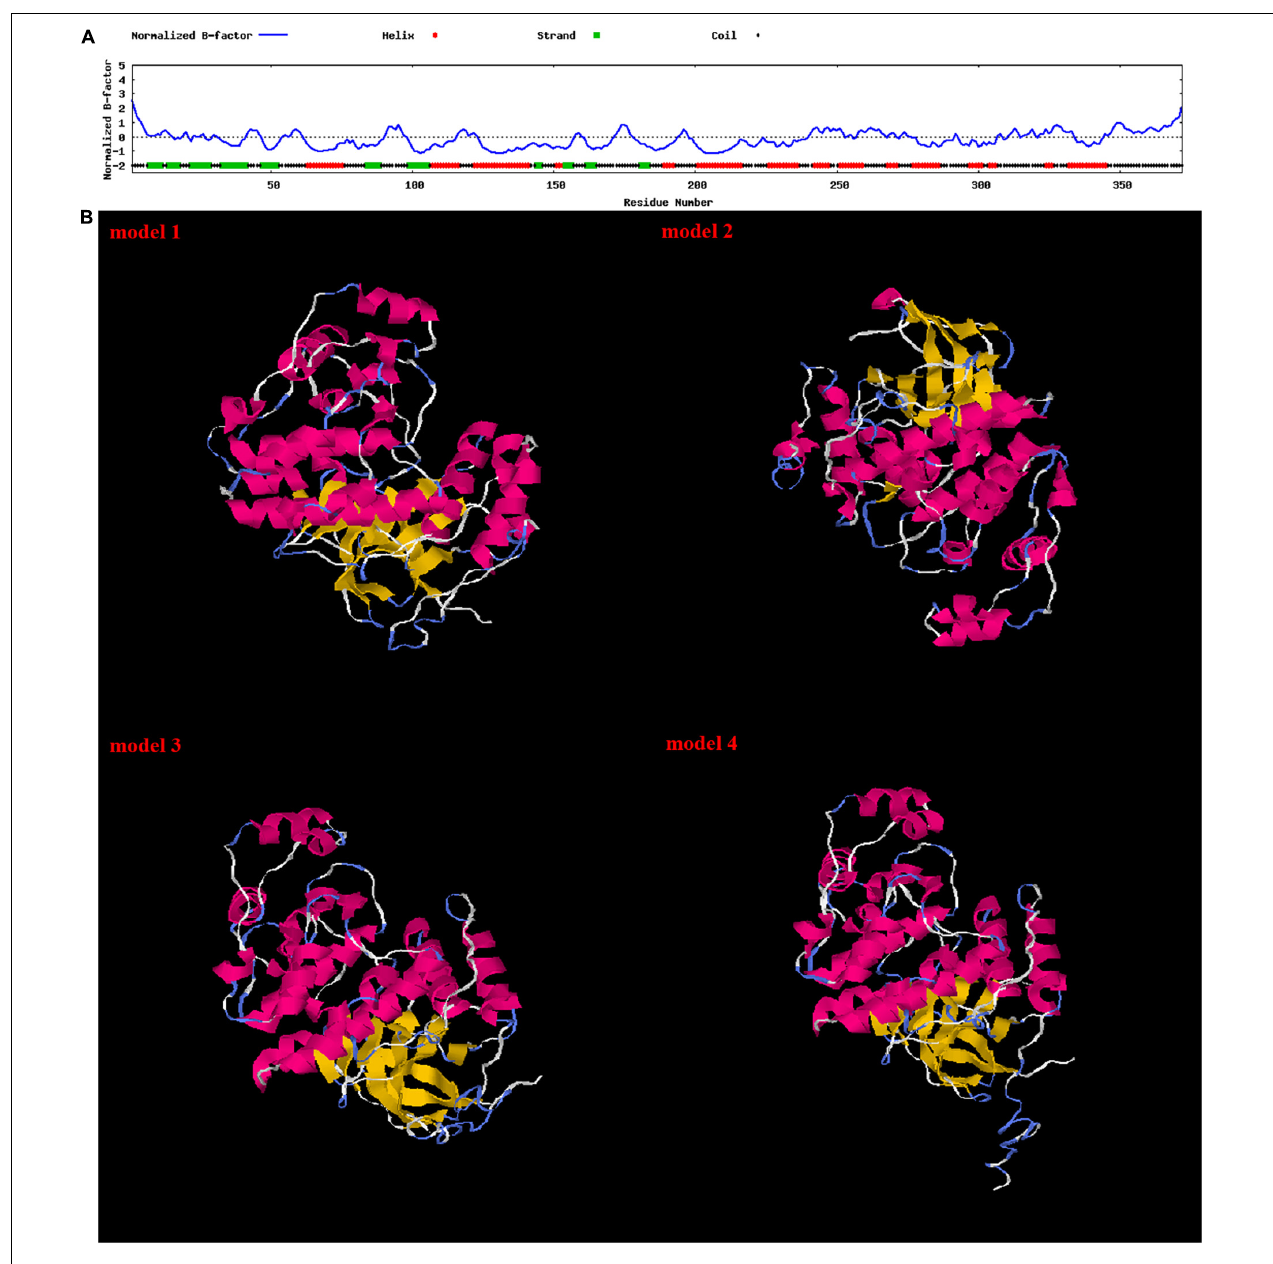
FIGURE 4 | Secondary structure and tertiary structure of the PtP38 protein. (A) Secondary structure of the PtP38 protein predicted by the I-TASSER website. (B) Tertiary structure of the PtP38 protein predicted by the I-TASSER website. PtP38 protein was composed of two halves, a N-terminal domain and a C-terminal domain. The N-terminal domain was composed largely of β -sheet, whereas the C-terminal domain was largely